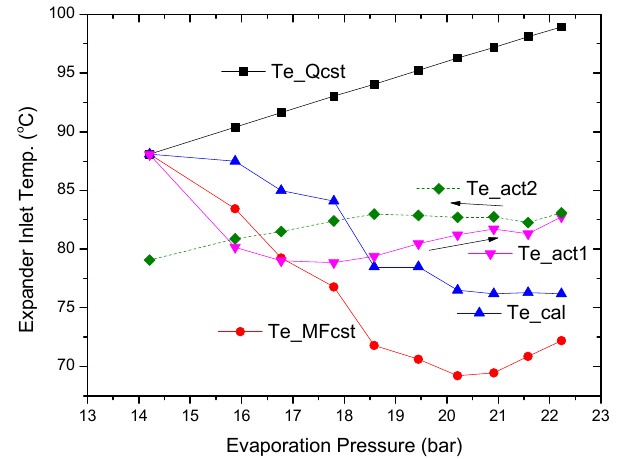
Figure 12. Expander inlet temperature with variation in evaporation pressure.